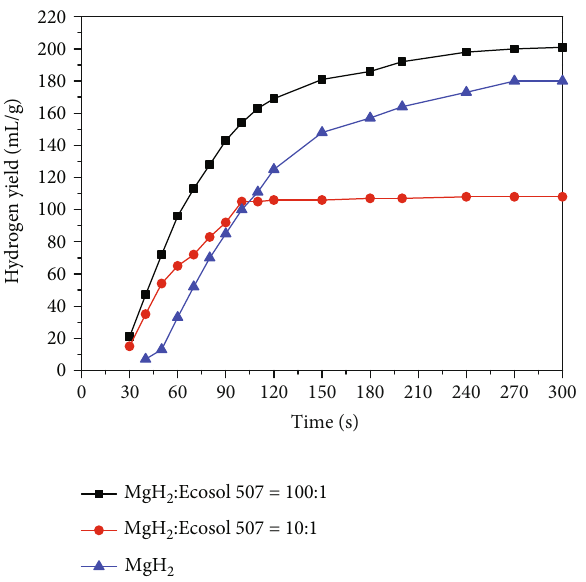
Figure 8: Comparison of hydrogen generation curves of MgH